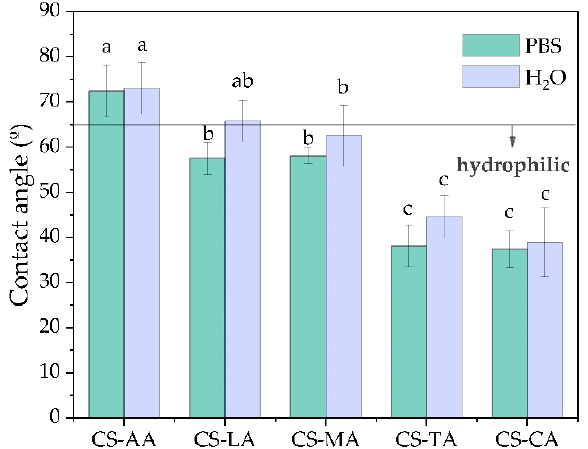
Figure 2. Phosphate buffered saline (PBS) and water contact angle values (average ± standard deviation) for the surface of shrimp chitosan films prepared with acetic, lactic, maleic, tartaric and citric acids. Values labeled with the same letter do not statistically differ from each other ( p > 0.05).